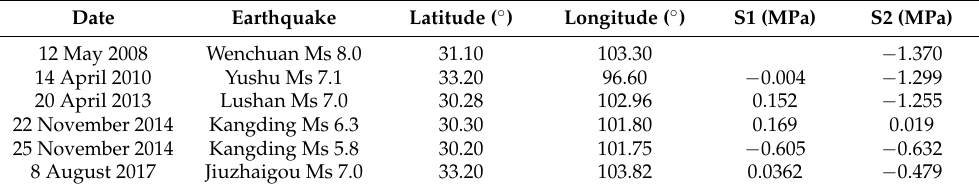
Table 4. Stress changes due to cumulative coseismic slip and postseismic relaxation. S1 indicates the stress changes induced by all the previous earthquakes. S2 refers to the stress changes caused by previous earthquakes and this event. When calculating the stress, the receiving fault is the source fault of this main earthquake. Six input motions were selected for this table because the six events are the largest in the past decade in the Sichuan area after the Ms 8.0 Wenchuan earthquake in 2008.